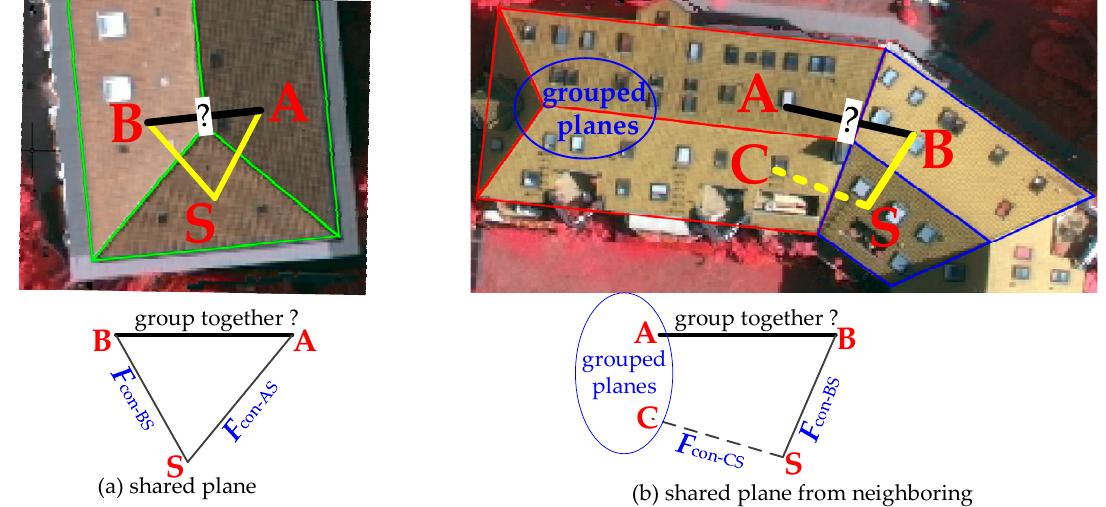
Figure 4. Illustration of the continuity law for grouping between plane ( a , b ).